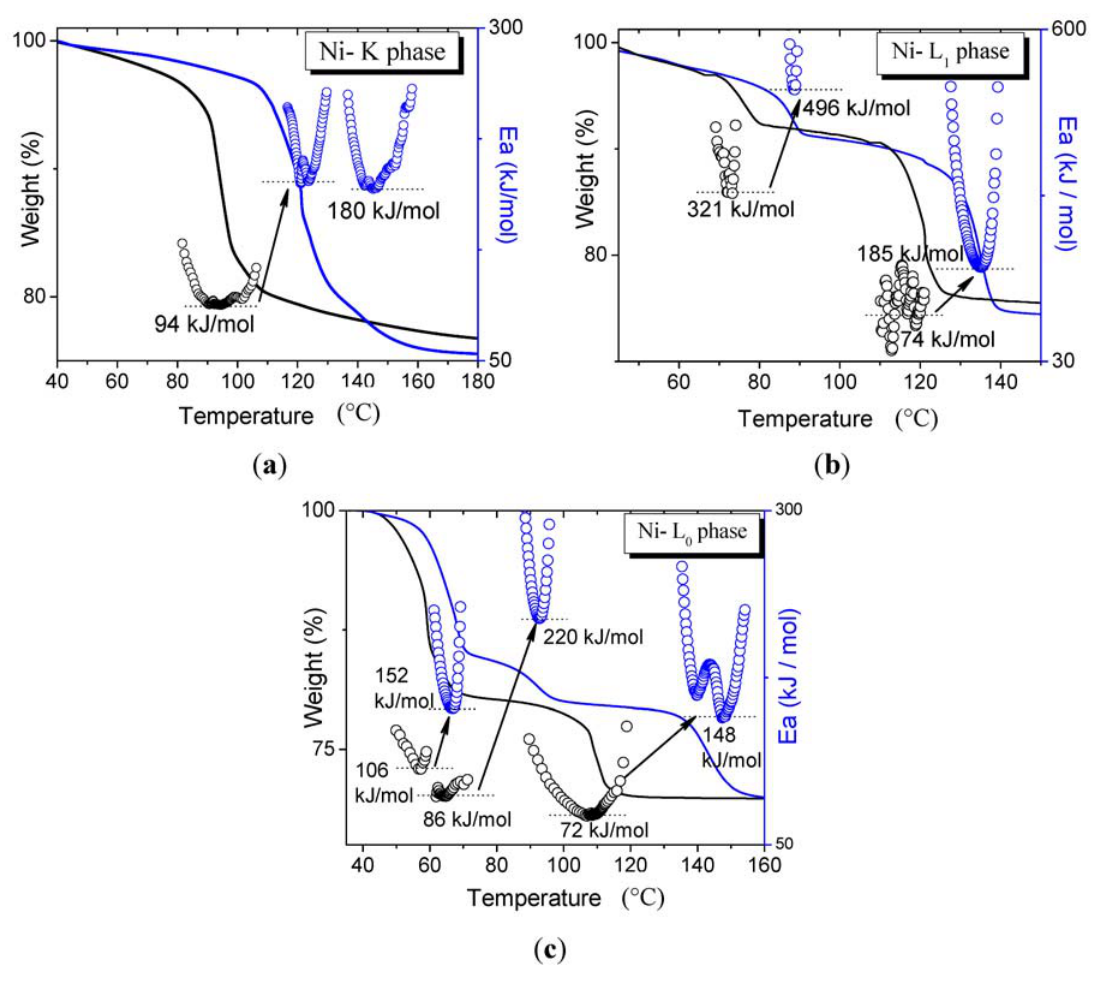
Figure 9. Thermogravimetric curves and their corresponding Ea profiles for ( a ) Ni-K phase; ( b ) Ni-L phase and ( c ) Ni-L phase. The data in blue corresponds to 1 0 samples under higher water partial pressure (3130 Pa), while plots in black represent the profiles without water. Arrows indicate the correspondence between each step, with and without the presence of